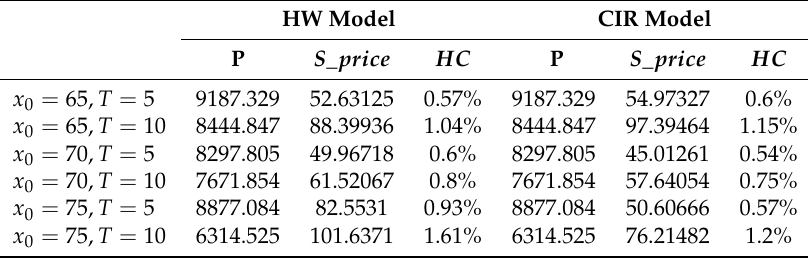
Table 5. Comparison between the prices of the pure endowment and S-forward